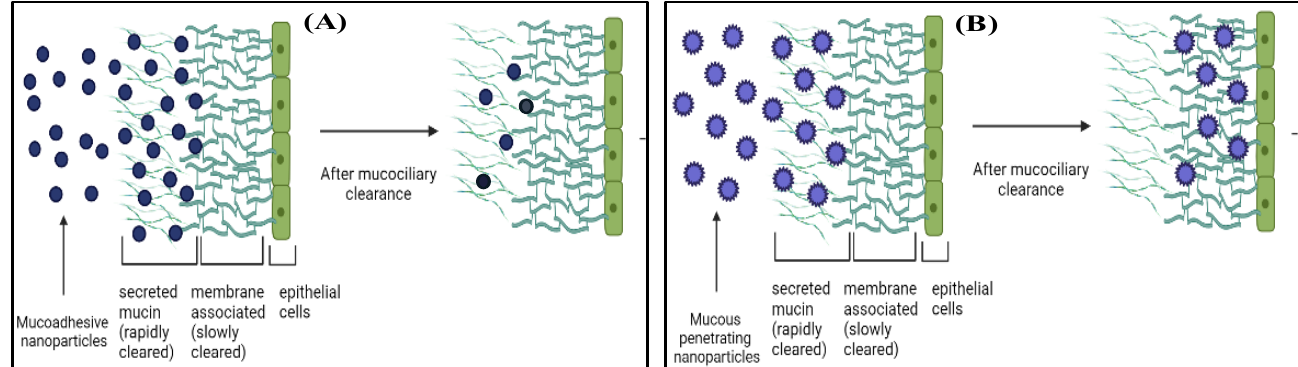
Figure 2. Graphical illustration of mucous layers and fate of ( A ) mucoadhesive, and ( B ) mucous penetrating nanoparticles after topical administration. MA-NPs adhere to the mucous layer of the cornea that clear off quickly with mucociliary clearance. At the same time MP-NPs penetrate deeper and tangle with static viscous mucous layer, thus lasting longer and proving more efficacious than MA-NPs.